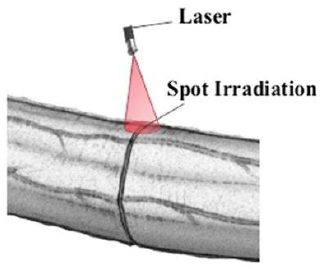
Figure 1. Schematics of laser welding of a nervous tissue [40].